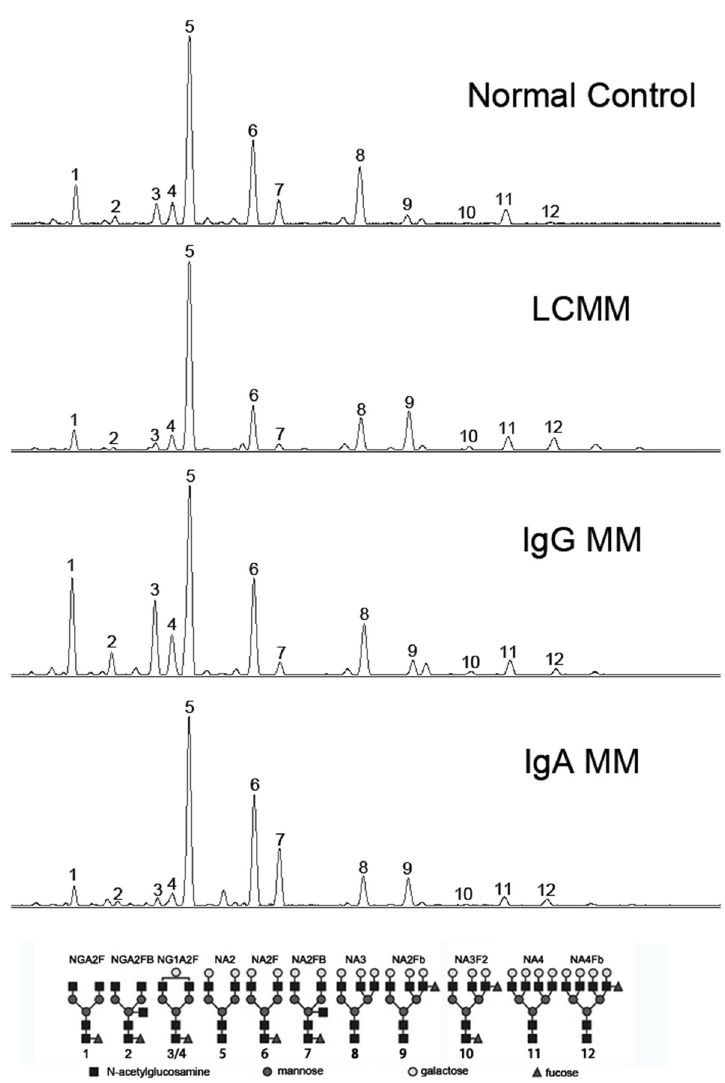
Fig 1. A representative N-glycan profiling of total serum glycoproteins. At least 12 peaks can be identified by DNA sequencer-assisted fluorophore-assisted capillary electrophoresis (DSA-FACE) technology in four groups. The structure of the N-glycan peaks and the symbols indicated the corresponding glycans are displayed below the